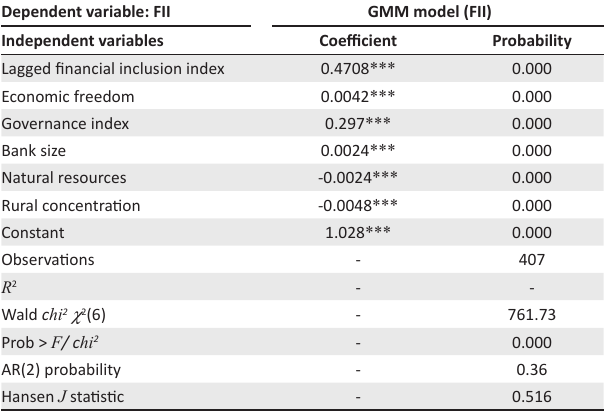
TABLE 6: The results from two-step generalised method of moments approach. Dependent variable: